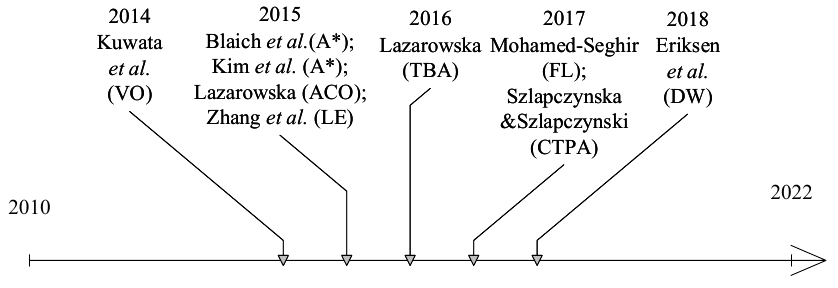
Figure 7. Timeline showing compared approaches from the years 2014–2018.